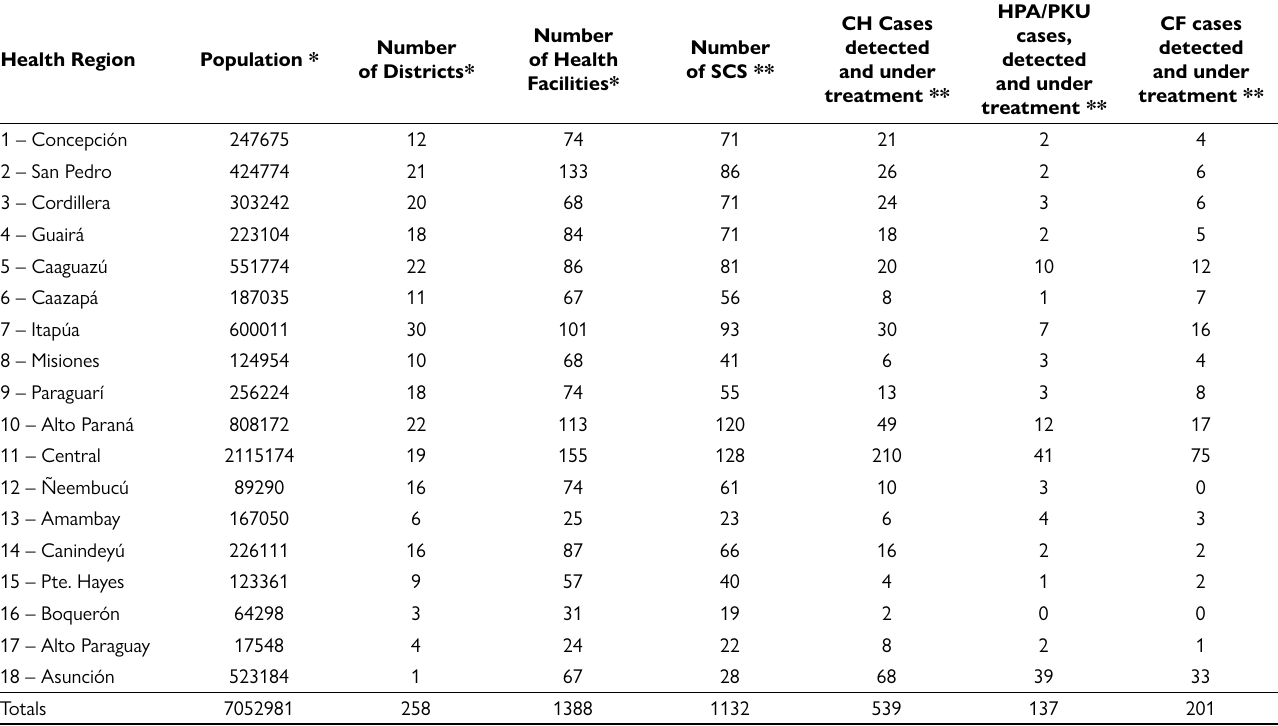
Table 2. Data by Health Region on the number of SCS, cases detected and in treatment, by pathology from October 1999 to October 2020.